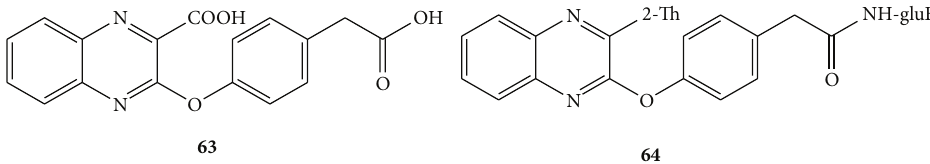
Figure 27: Chemical structures of compounds tested.